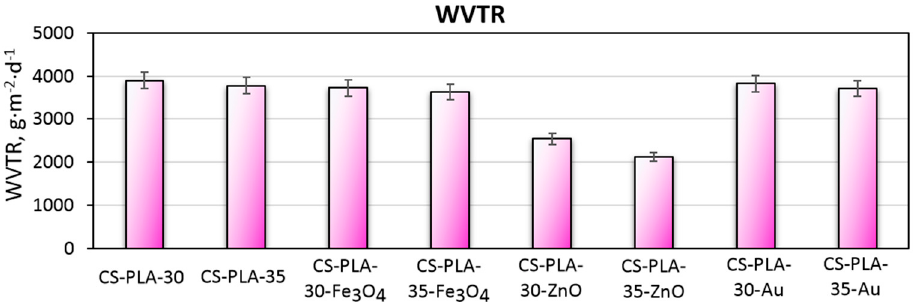
Figure 5. Water vapor transmission rate of the prepared scaffolds.